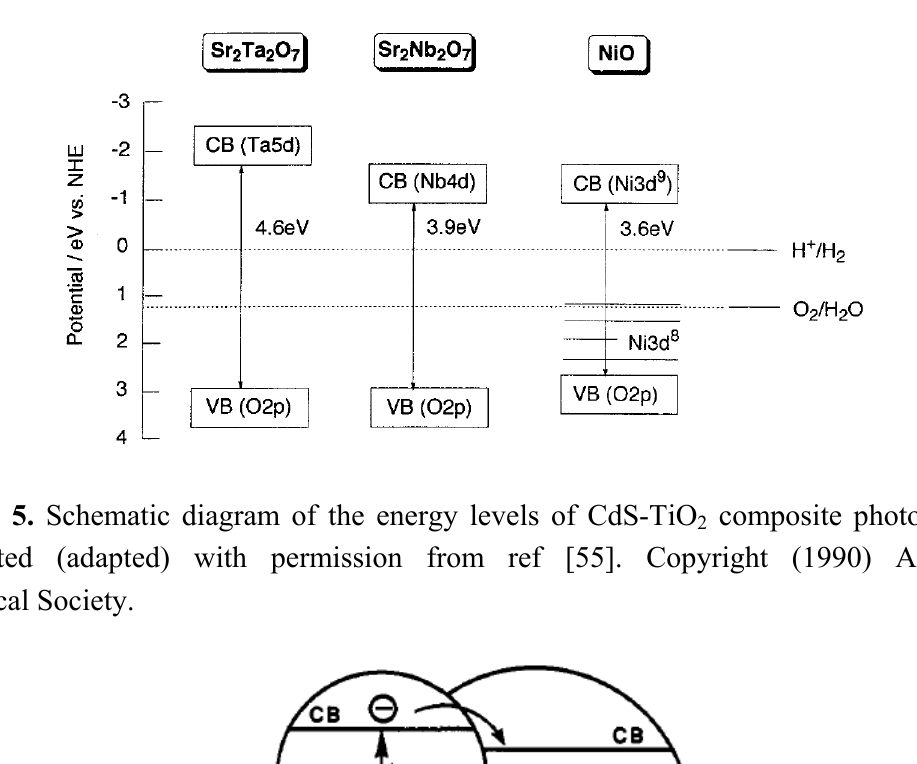
Figure 4. Band structures of Sr co-catalyst Reprinted (adapted) with permission from ref [50]. Copyright (2000) American Chemical Society.